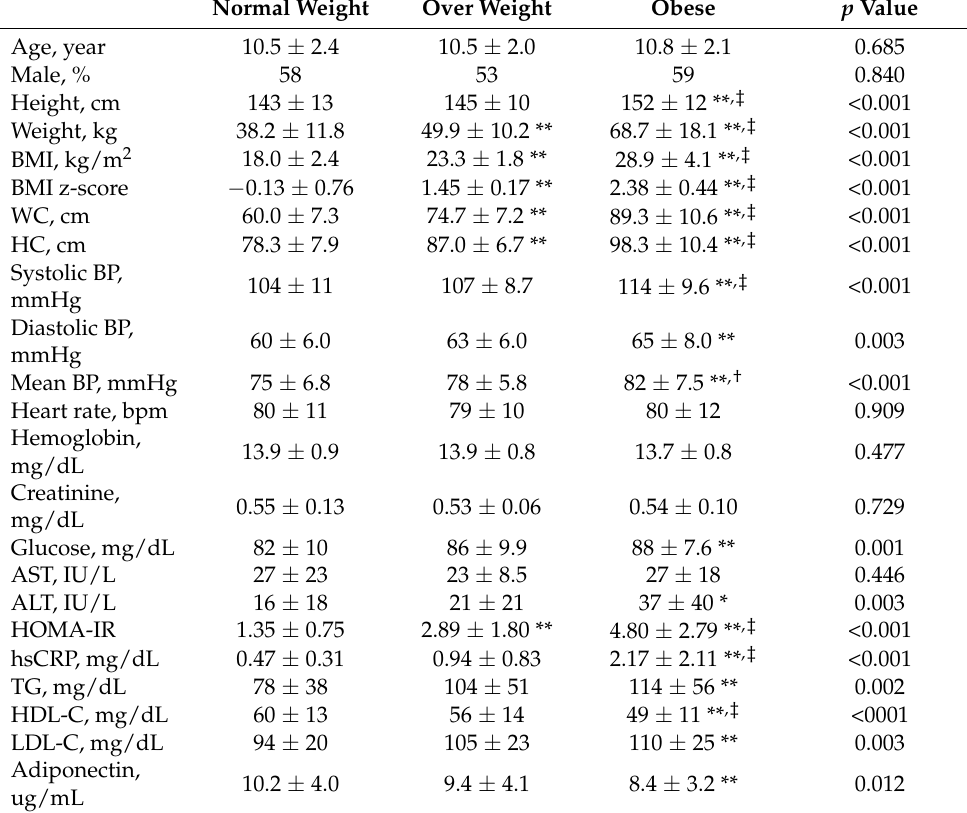
Table 1. Baseline characteristics.